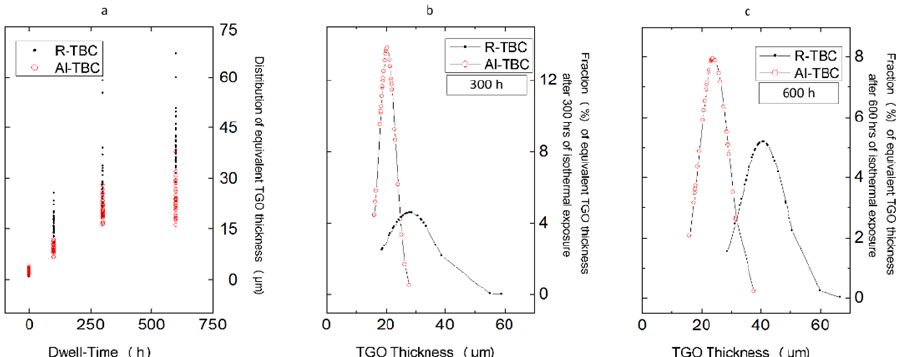
Figure 7. Analysis of TGO formation: ( a ) the effect of dwell time duration at 1150 °C on the equiva- lent TGO thicknesses; ( b ) normal distribution of equivalent TGO thicknesses after 300 h; and ( c ) normal distribution of equivalent TGO thicknesses after 600 h of isothermal exposure.